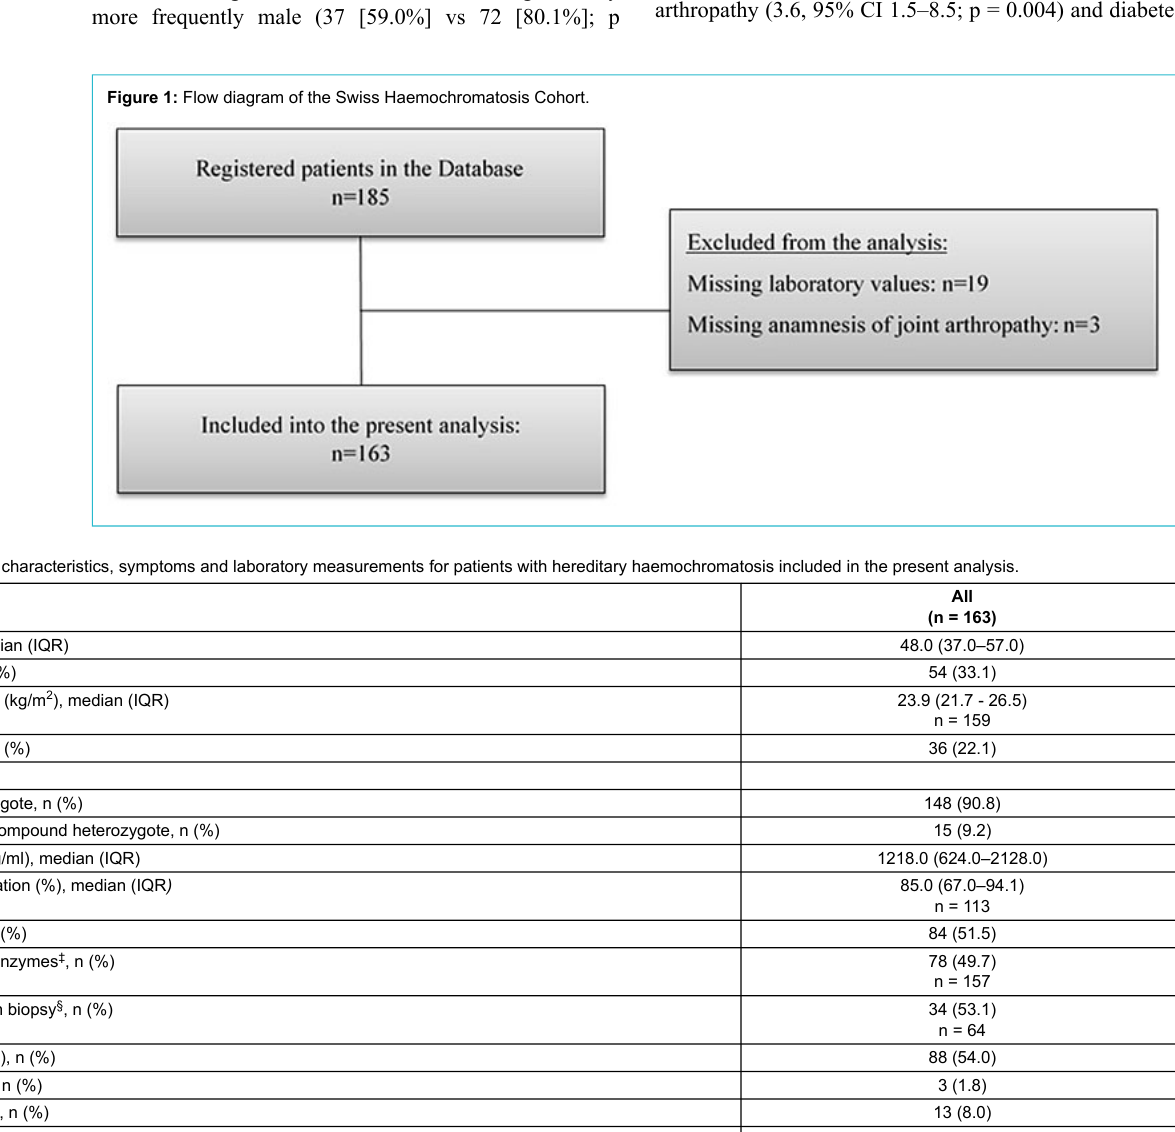
Figure 1: Flow diagram of the Swiss Haemochromatosis Cohort.